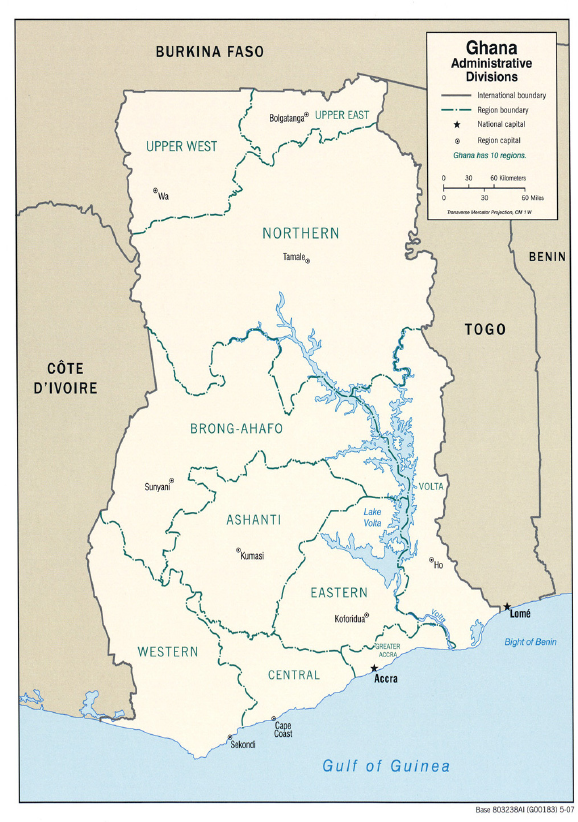
Fig. 1. Ghana administrative